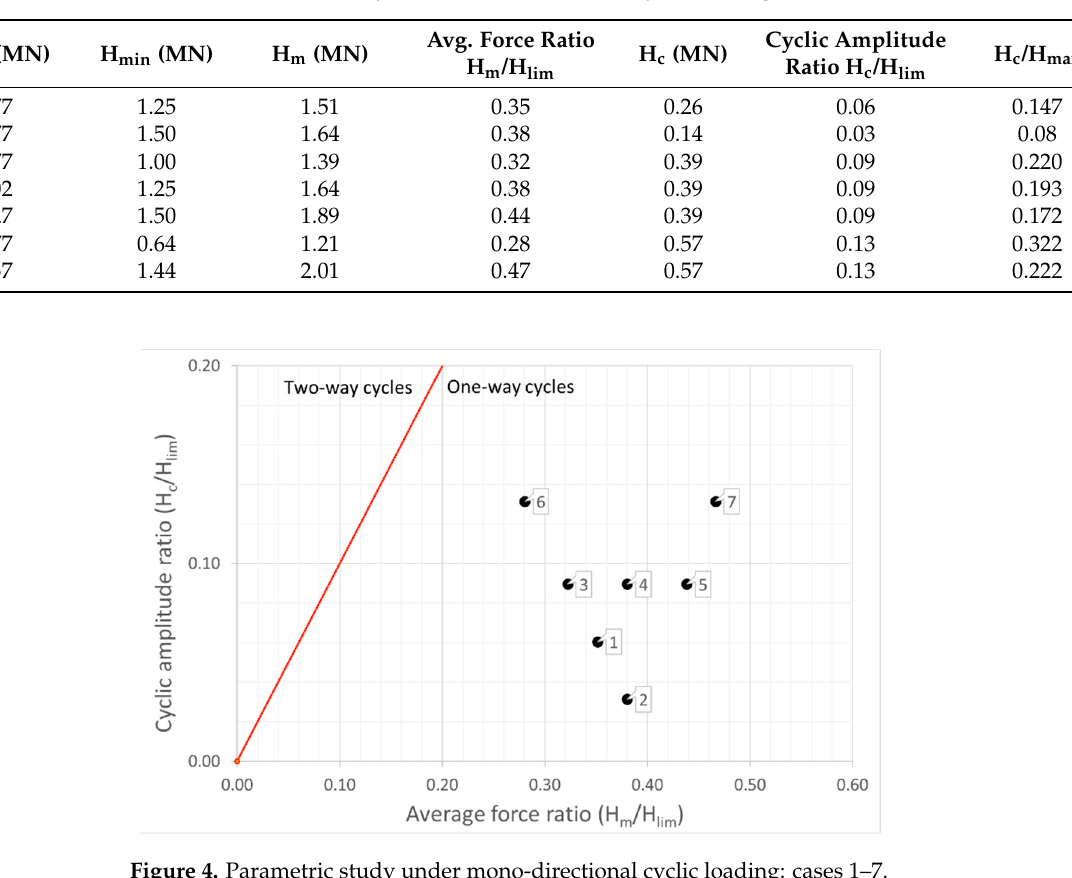
Table 1. Parametric study under mono-directional cyclic loading.